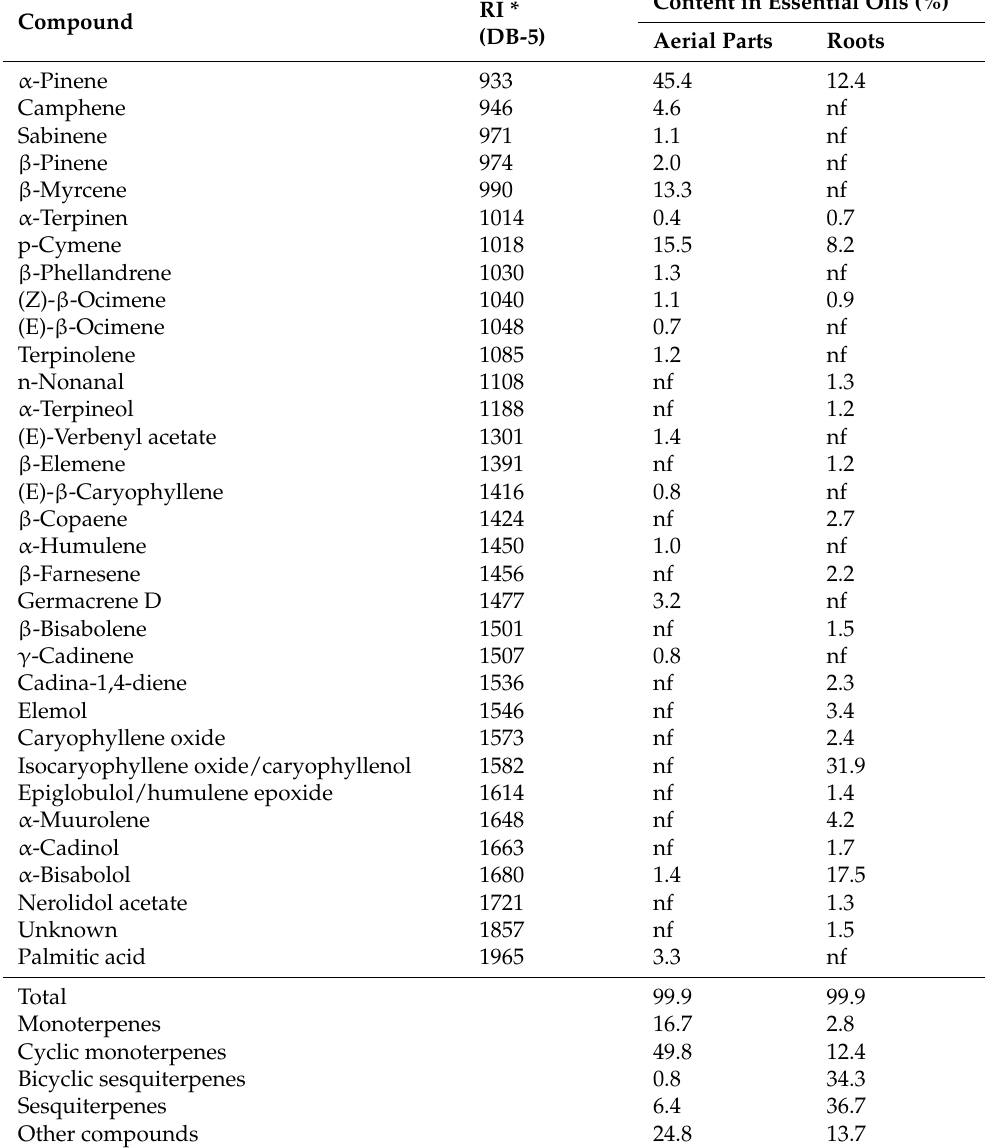
Table 2. Essential oils content of aerial parts and roots of Angelica sylvestris